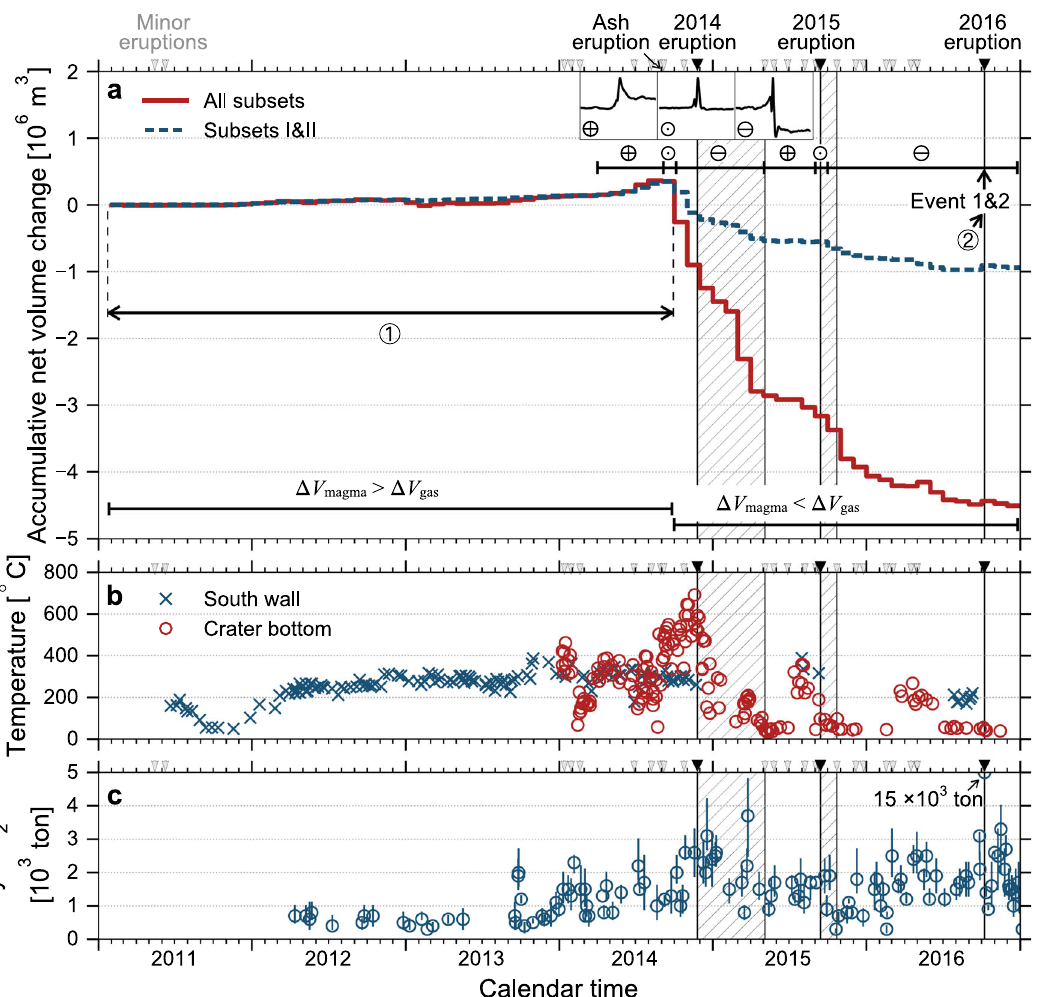
Fig. 5 Tracking the net volume change in the SMSZ, crater bottom (wall) temperature, and SO 2 emission during the 2011 – 2016 eruption cycle. a The accumulative net volume changes in the SMSZ. Dark inverse triangles mark the onset of the 2014 Strombolian eruption, the 2015 and 2016 phreatomagmatic eruptions, whereas hatched areas mark their eruption episodes. Grey inverse triangles indicate minor eruptions. The volume changes from the high-quality subsets I + II are shown in blue dotted line. Enclosed plus, minus, and dot mark the episodes associated with observations of prominent in fl ation event, de fl ation event, and event of negligible offset, respectively (see waveform stacks in the insets). Enclosed 1 and 2 mark the time windows where the mass changes in the SMSZ before the 2014 and 2016 eruptions are calculated, respectively (see also Fig. 6a). b Crater-bottom temperature measured from the Naka-dake fi rst crater (red circle), provided by JMA 33 and Cigolini et al. 79 ; South wall temperature (blue circle) is provided by JMA 33 . c SO 2 emission from the campaign ground-based sensor, provided by JMA 33